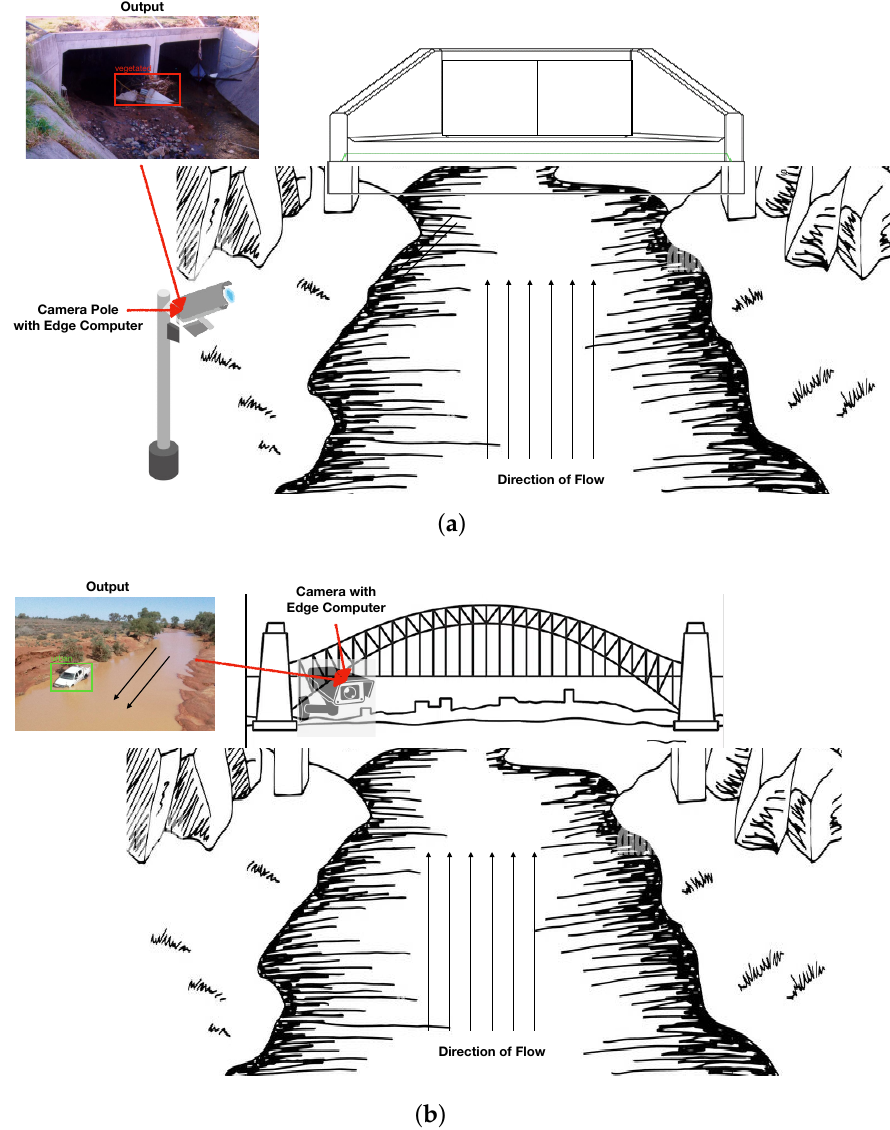
Figure 9. Graphical Illustration of Two Potential Use Cases for the Proposed Floodborne Object Type Recognition using Computer Vision: ( a ) Culvert Use Case, ( b ) River Use